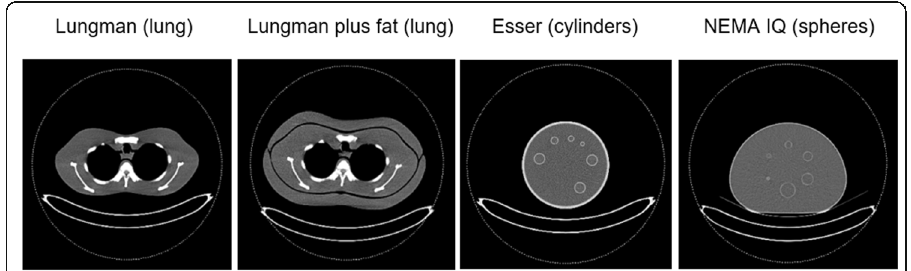
Fig. 1. Lungman represents a normal-sized adult male chest and is 430 mm wide, 400 mm deep and 480 mm high, with a chest girth of 94 cm. The phantom is comprised of soft tissue made of polyurethane and bone made of synthetic epoxy resin. Lungman plus fat is made by attaching anterior and posterior polyurethane plates to Lungman, each of 30-mm thickness, thereby representing an overweight adult male chest. The Esser phantom is a water-filled acrylic cylindrical phantom of 204 mm diameter and 186 mm height used primarily for SPECT and PET image quality assessment. The phantom has a circumference of 64 cm, correlating to the waist measurement of a child from age 10 to early teens [18]. The phantom comprises six cold spheres and a com- partment of rods which were included in the phantom scans but not used as part of the tracer activity evaluation. Six cylinders of height 38 mm are suspended from the phantom lid. Three cylinders have a diameter of 25 mm (volume 18.7 mL) which were used for evaluation of tracer activity concentration in this study. The remaining three cylinders have diameters and volumes of 16 mm (7.6 mL), 12 mm (4.31 mL) and 0.8 mm (1.92 mL), which were filled with activity but not used as part of the tracer activity concentration evaluation, involving accurate placement of a 1-cm 3 volume of interest (VOI). The NEMA IQ phantom is a water-filled acrylic phantom representing the size and shape of an adult abdomen and is used primarily for PET image quality assessment. The phantom is 300 mm wide (left to right), 230 mm deep (anterior to posterior) and 220 mm high and with a circumference of 87 cm correlates to the waist measurement of an overweight adult female [19]. It contains six spheres suspended in the central part of the phantom of diameter 10, 13, 17, 22, 28 and 37 mm. A cylindrical lung insert is ation of the phantom, and only the measured activity concentrations in the